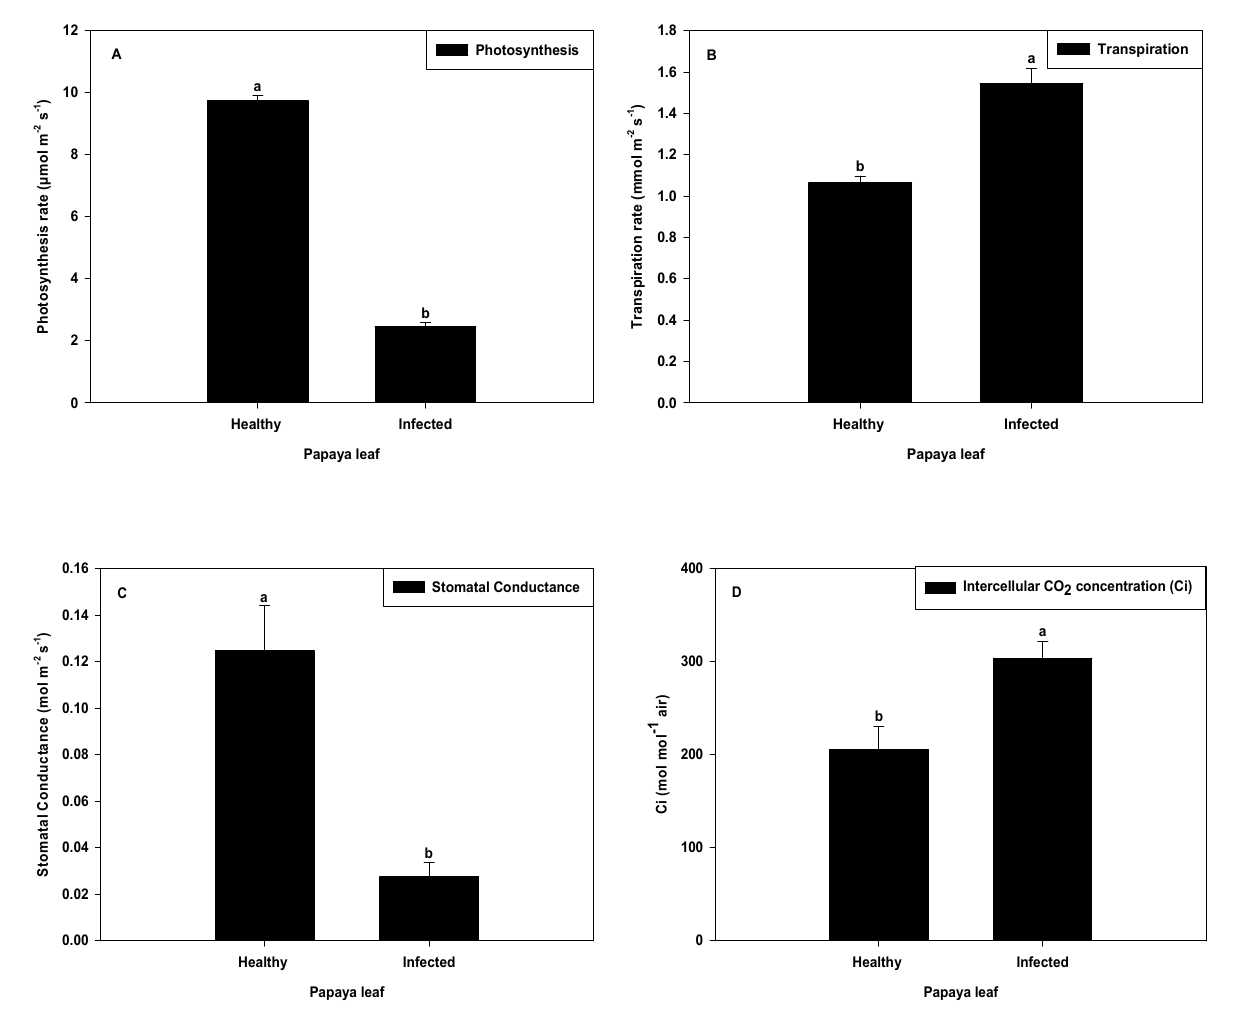
Figure 4. Effect of PaLCuV virus infection on ( A ) photosynthesis rate, ( B ) stomatal conductance, ( C ) transpiration rate, and ( D ) intercellular CO 2 concentration. Error bars shown as the standard error of mean (SE) was computed by Sigma Plot 14, different letters above the error bars show significant differences at p ≤